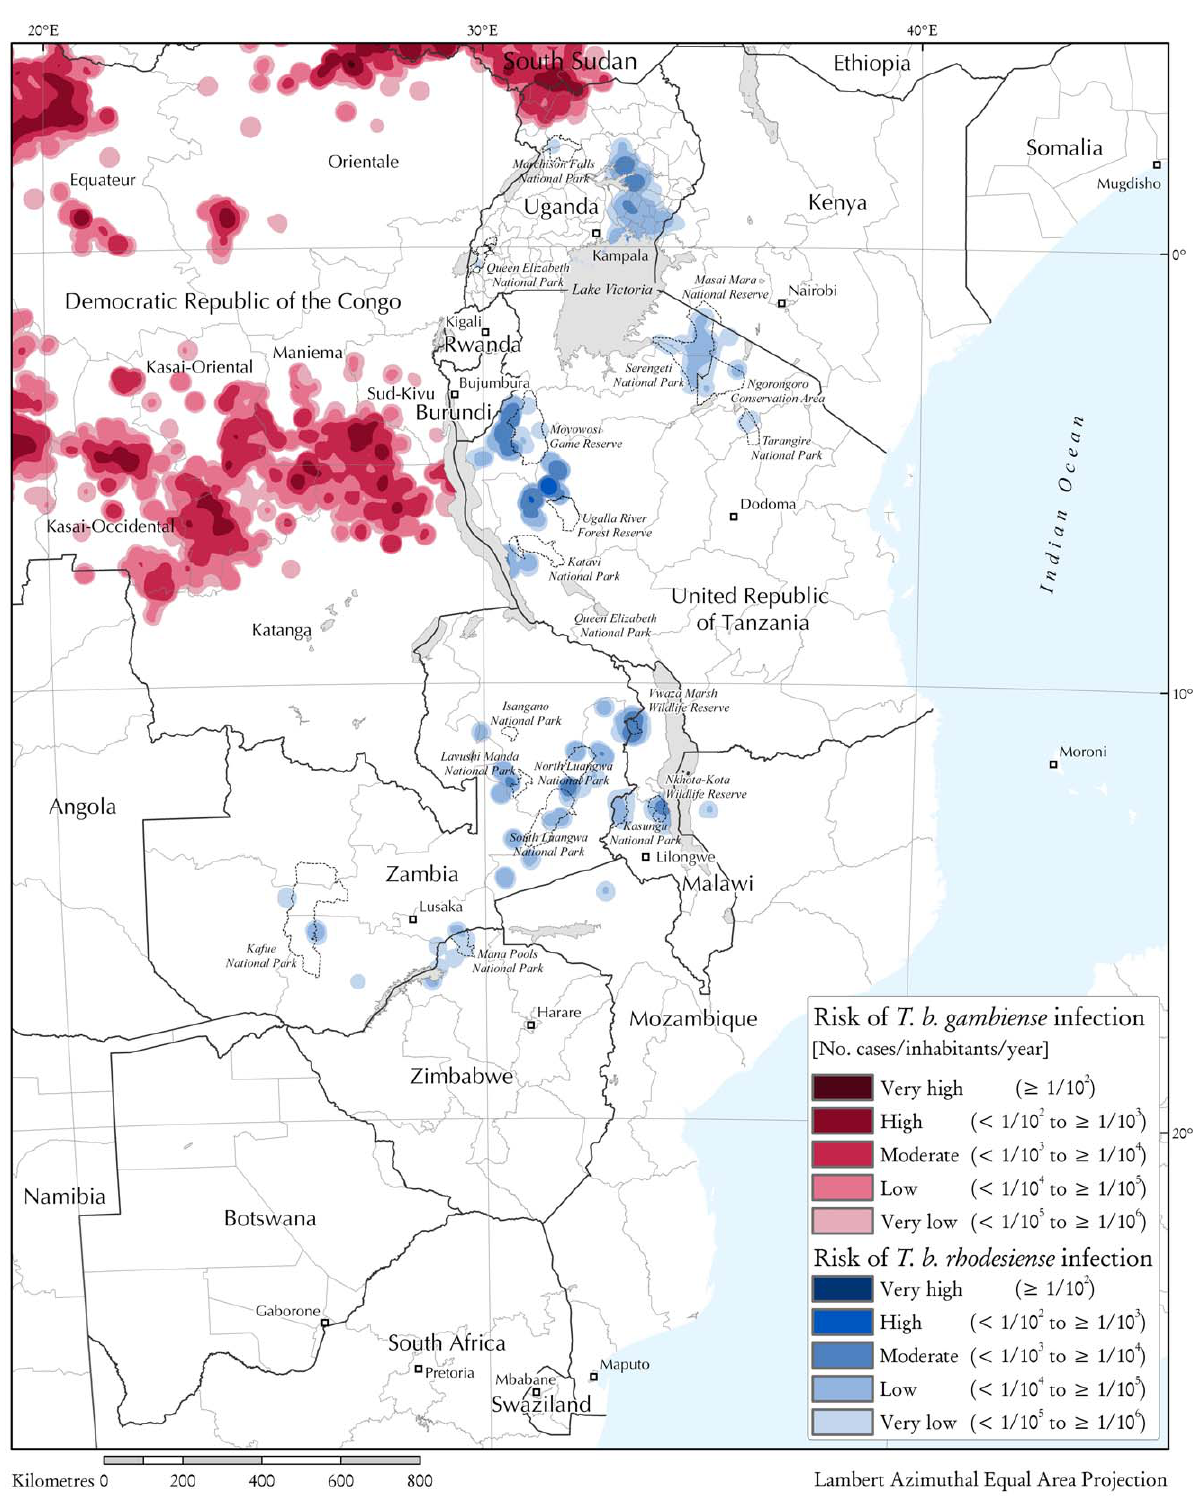
Figure 5. The risk of T.b.rhodesiense infection in eastern and southern Africa (2000–2009).